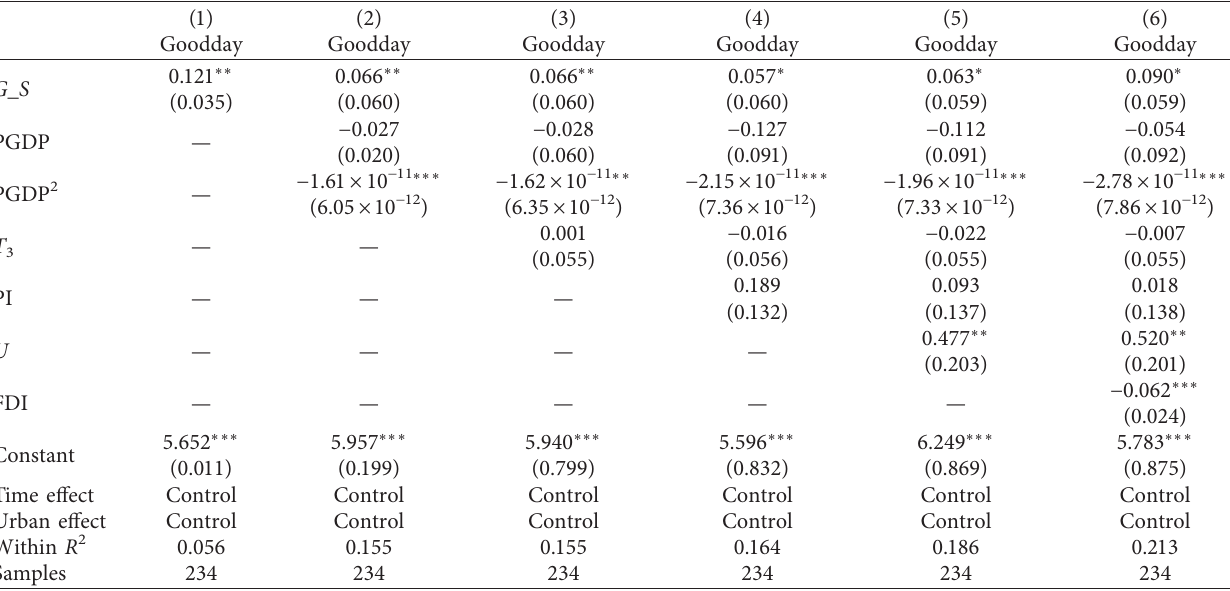
Table 5: Test of spillover effects in the central city circle.